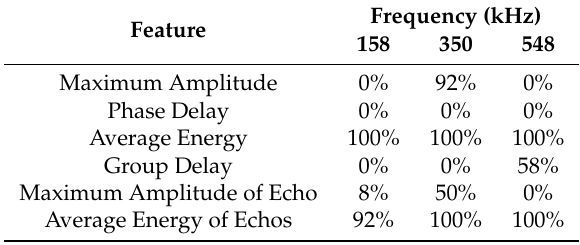
Table 2. Ratios of selection of the features, including echo features.